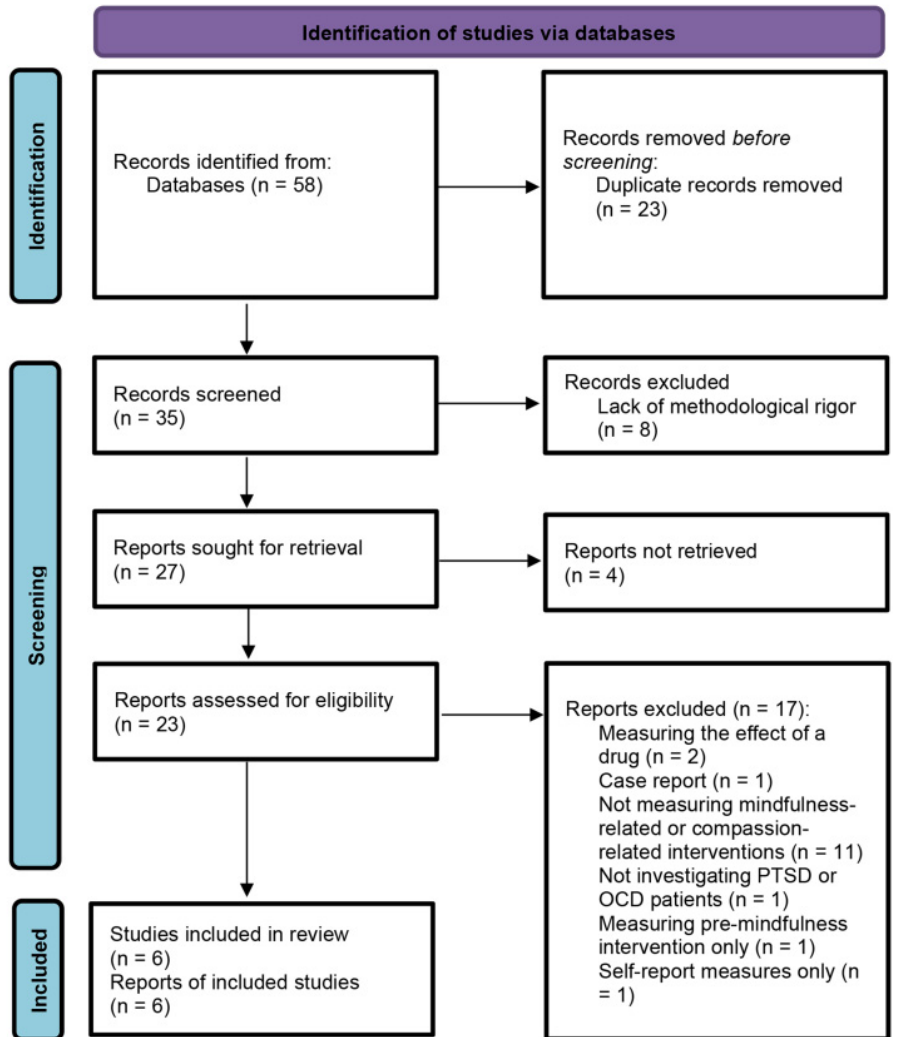
Figure 1. PRISMA 2020 flow chart for literature search and screening results.